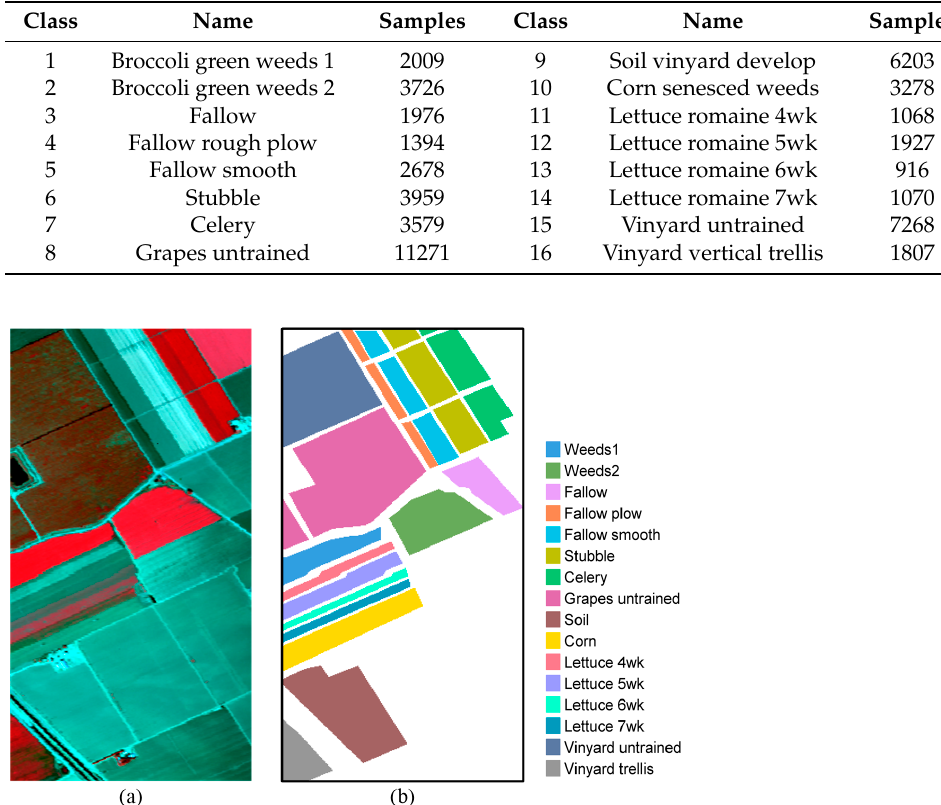
Table 3. Sixteen ground-truth classes of the Salinas data set.